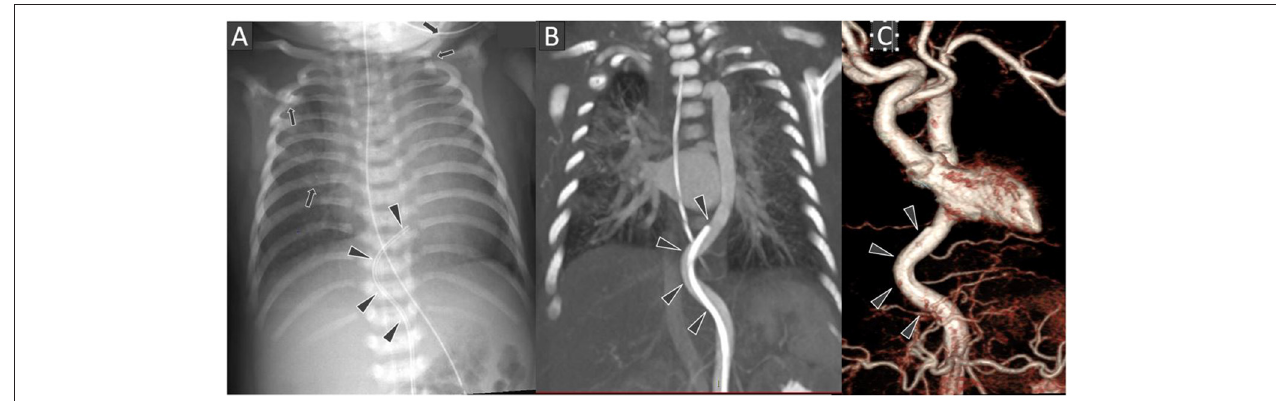
FIGURE 1 | Frontal chest radiograph (A) shows the tip of the umbilical arterial catheter (UAC) at the level of T8 vertebral body with curved configuration of its terminal portion (black arrowheads). Several rib and left clavicular fractures (black arrows) are also noted in the bony thoracic cage. Chest CT Angiography coronal multi-planar reconstruction image at the level of thoraco-abdominal aorta (B) and 3D surface shaded display image of the thoraco-abdominal aorta (C) showing the arterial tortuosity with distal end of the UAC location in descending thoracic aorta.